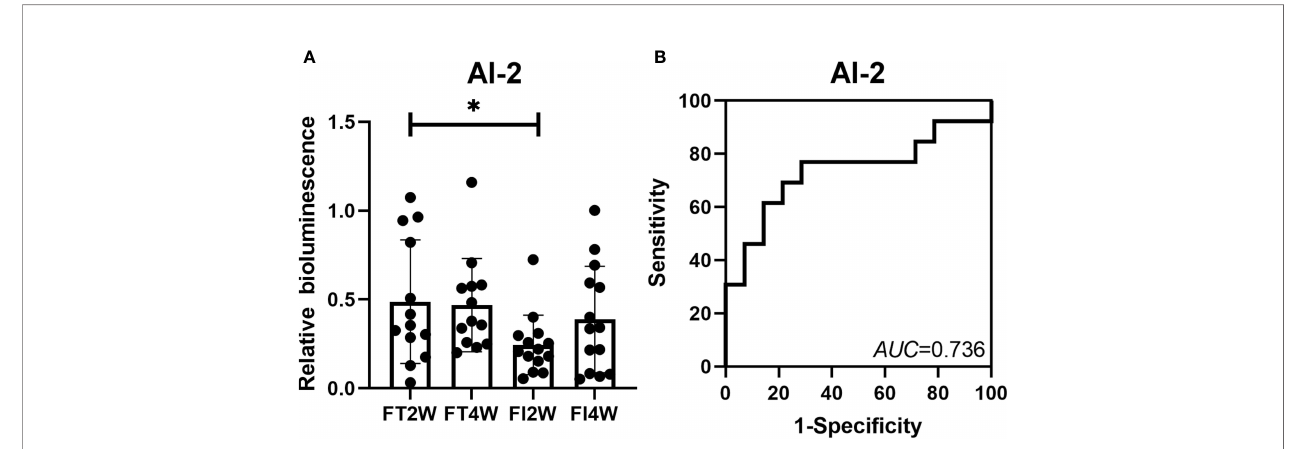
FIGURE 7 | Change in AI-2 level in the FT and FI groups and the value of AI-2 in the prediction of FI. The level of AI-2 was lower in the FI group than in the FT group at 2 weeks of life, and there was no difference between the two groups at 4 weeks after birth (A) . The AUC for AI-2 at 2 weeks of life was 0.736 (B) . * P < 0.05.